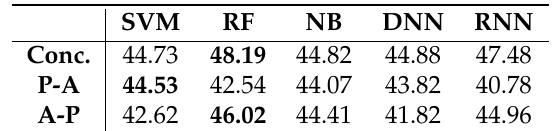
Table 11. Accuracies of concurrent, possession-action, and action-possession recognition under one-user-out cross